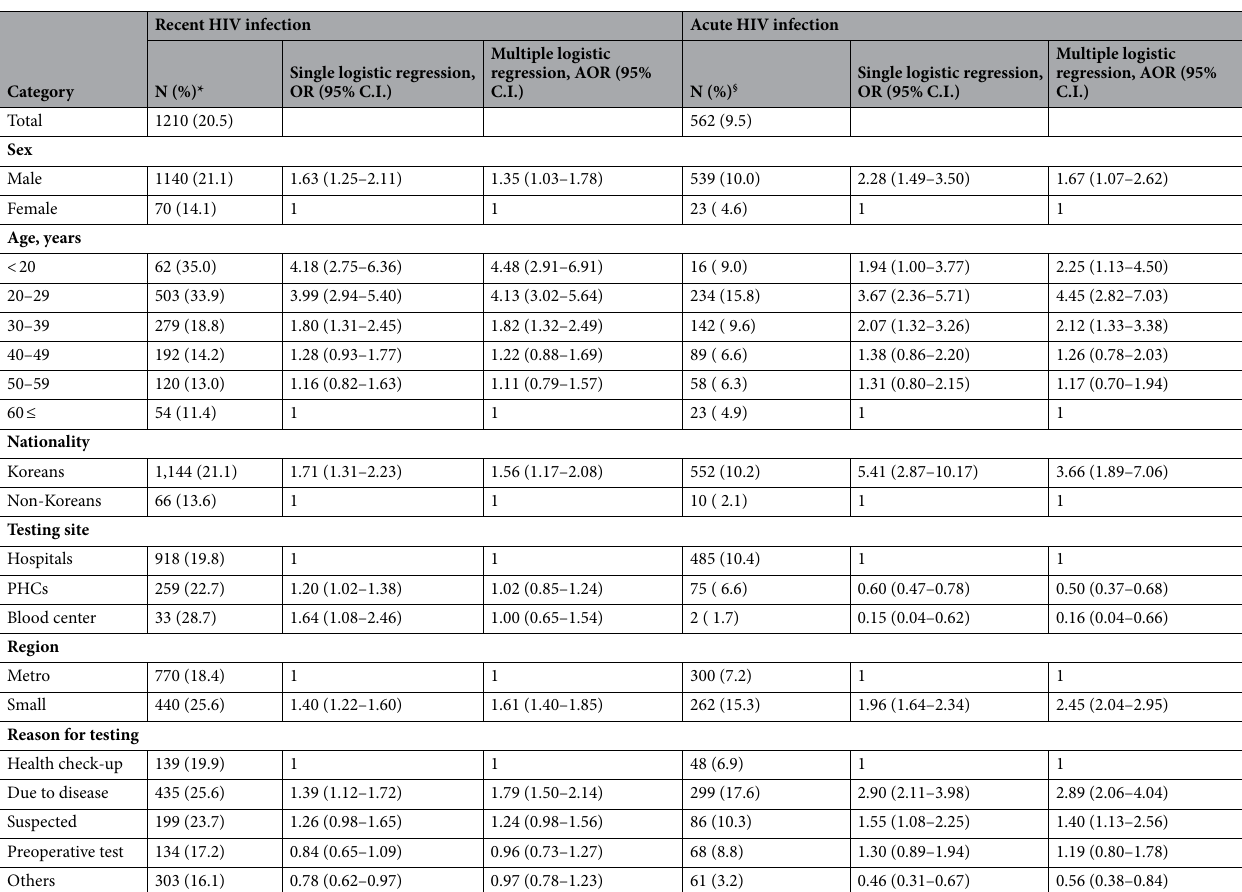
Table 2. The logistic regression analysis of characteristics of the recent HIV infection including acute HIV infection in Korea from 2008 to 2015. *Proportion of recent HIV infection among specimen for recent HIV testing. § Proportion of acute HIV infection among specimen for recent HIV testing. PHCs public health centers, metro metropolis, small smaller city or rural area, others prenatal check-up, blood donation, partner of HIV positive, sexual transmitted infection risk group, etc., OR odds ratio, AOR adjusted (sex, age,